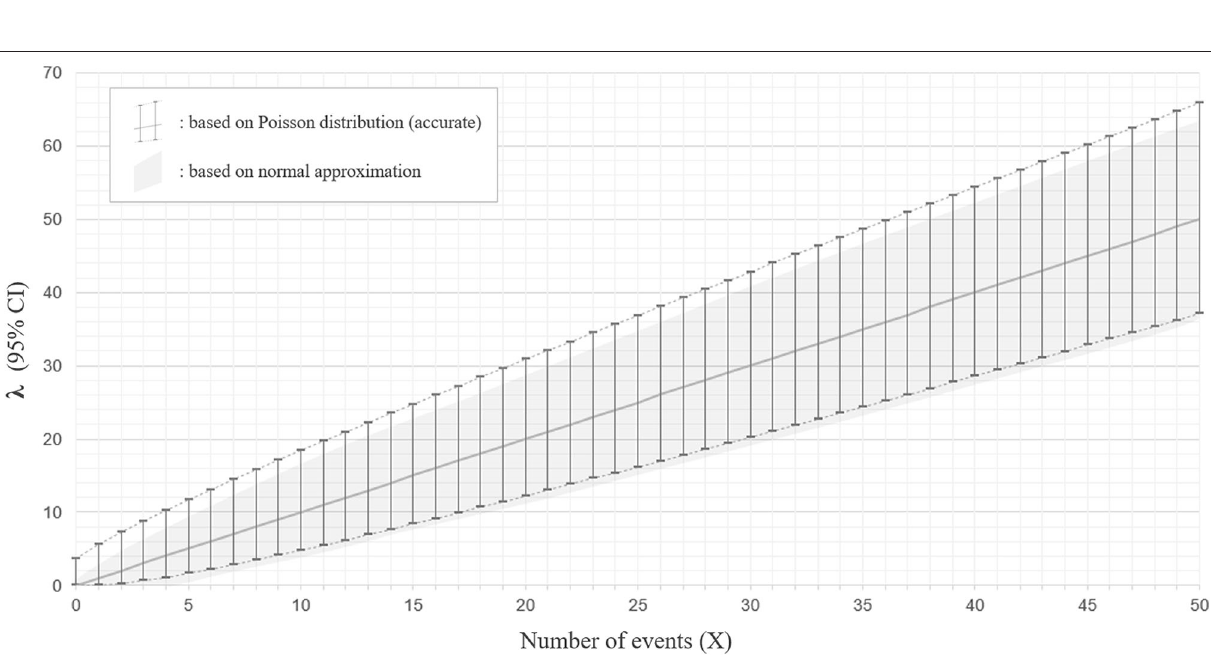
Frontiers in Neurology |